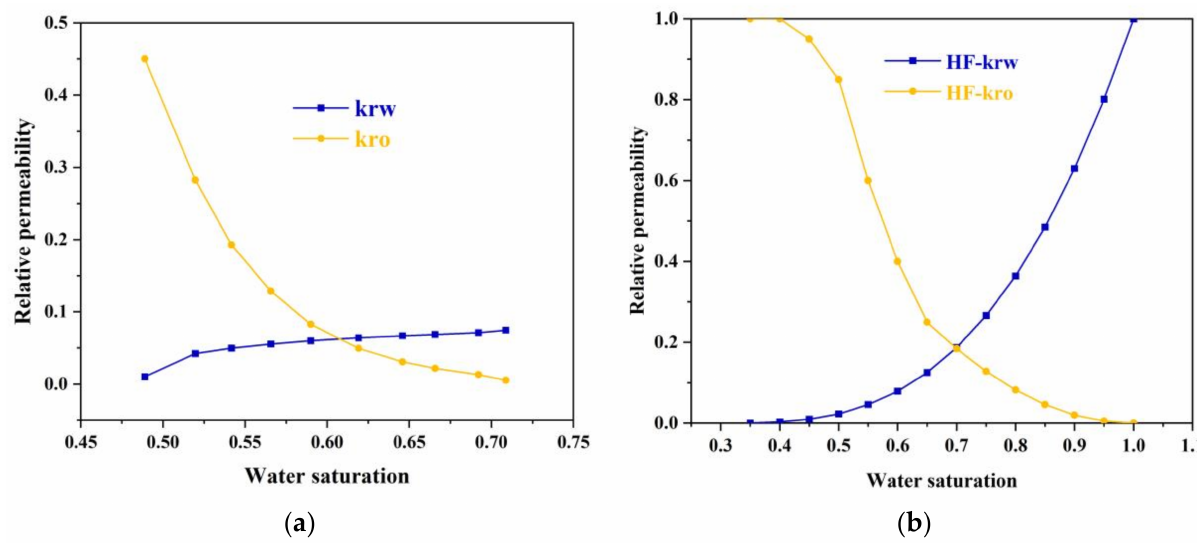
Figure 2. Relative permeability of: ( a ) matrix; ( b ) hydraulic